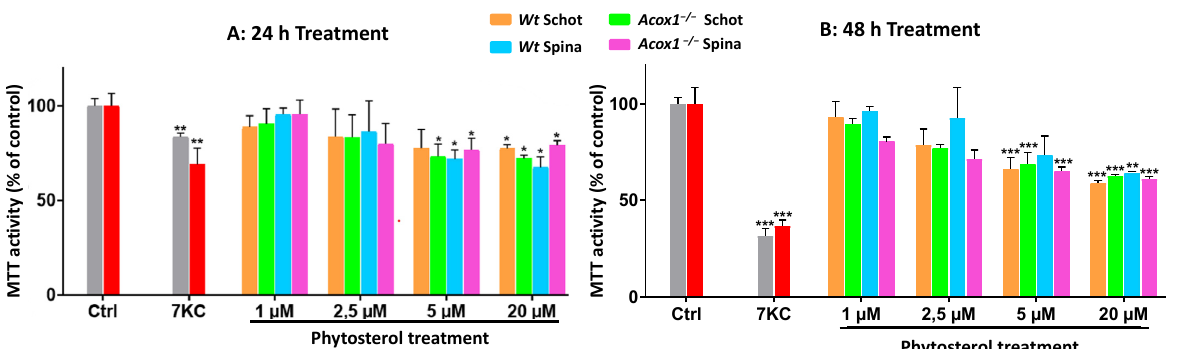
Figure 1. Effects of Schot and Spina on the cell proliferation and viability of the Wt and the Acox1 − / − BV-2 microglial cells for 24 ( A ) or 48 ( B ) hours. Cell proliferation and viability were assessed by the MTT test. Cells were treated with Schot or Spina at a range of concentrations from 1 to 20 µM. 7-ketocholesterol (7-KC) was used at 20 µM as a positive control. All compounds were tested for 24 or 48 h. All values are presented as means ± SD of two independent experiments performed in triplicate. Values were normalized to the control. Statistical significance compared to control (*** p ≤ 0.001, ** p ≤ 0.01, * p ≤ 0.05) was determined using one-way ANOVA followed by Tukey’s test.